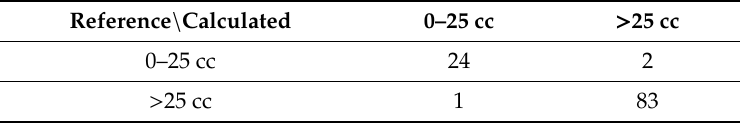
Table 3. Confusion matrix for classifying lesion severity by